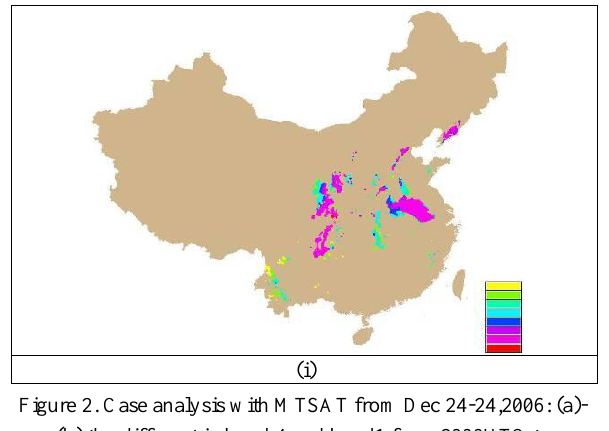
Figure 2. Case analysis with MTSAT from Dec 24-24,2006: (a)- (h) the different in band 4 and band1 from 2333UTC to 0633UTC, (i) the fog distribution map with different duration(from yellow to red, continuance from 1 hour to 8 hours) Remote sensing In-situ Fog No fog Fog 36 65 No fog 412 overall accuracy 83.27% Kappa coefficient Table 2. Accuracy